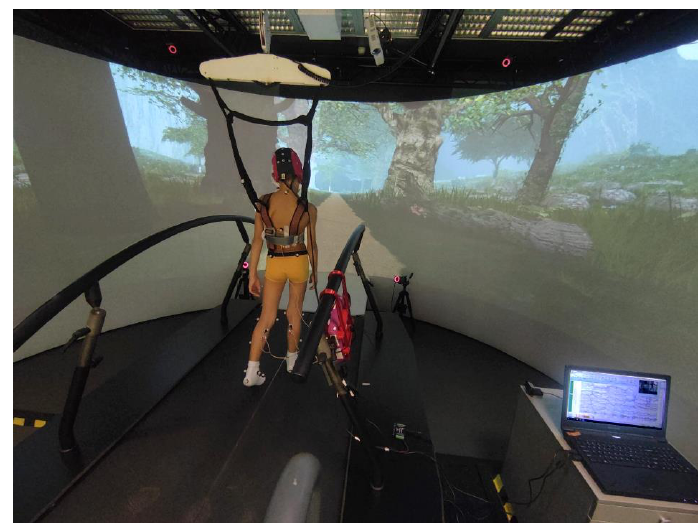
Figure 4. Multimodal recording during gait training in VR environment.